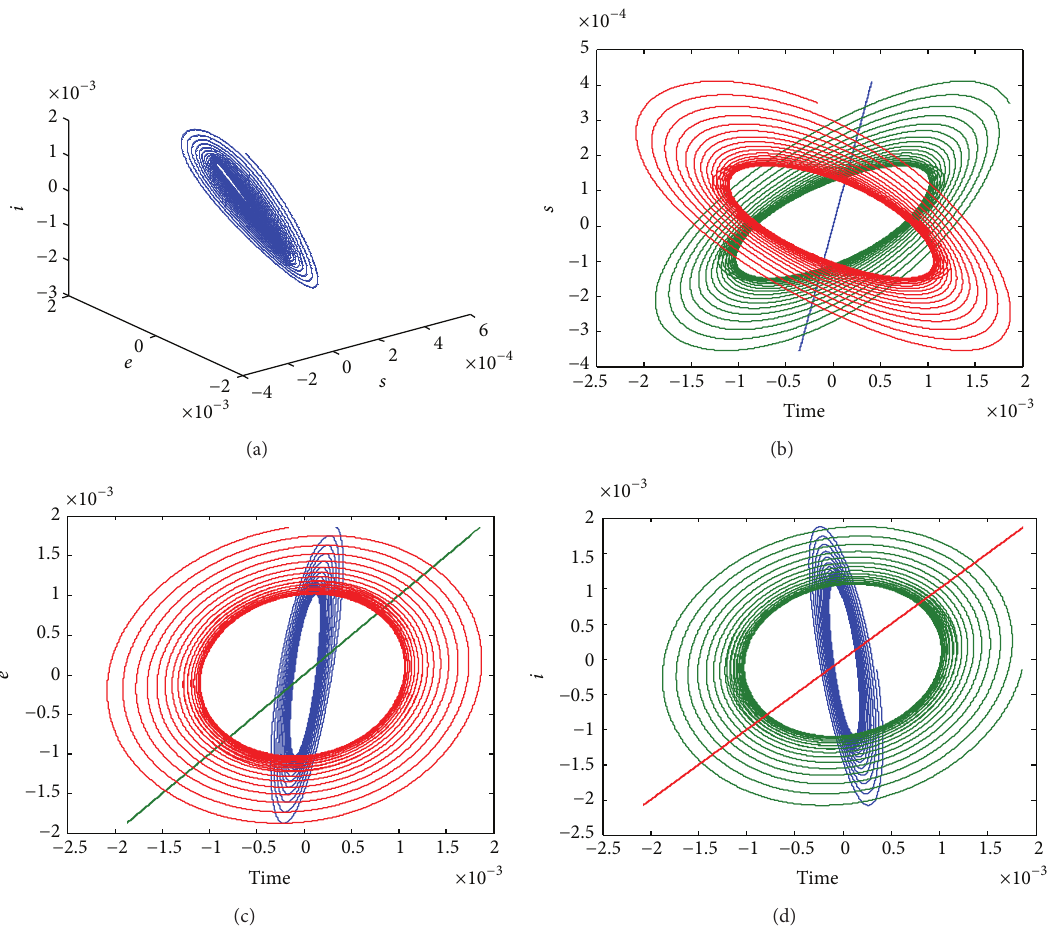
Figure 1: (a) Phase portraits of (2). (b) Time series of 𝑠 . (c) Time series of 𝑒 . (d) Time series of 𝑖